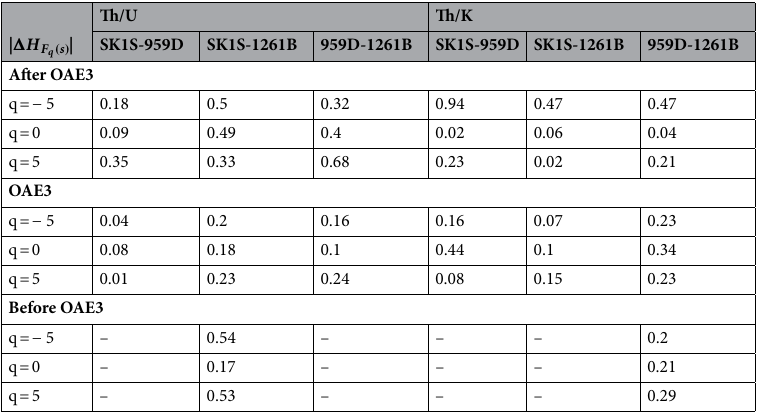
Table 1. Slope difference of the fluctuation functions of the thorium–uranium and thorium–potassium distributions between localities before, within and after the OAE3 intervals. SK1S (Songliao Basin), 959D (Deep Ivorian Basin), and 1261B (Demerara